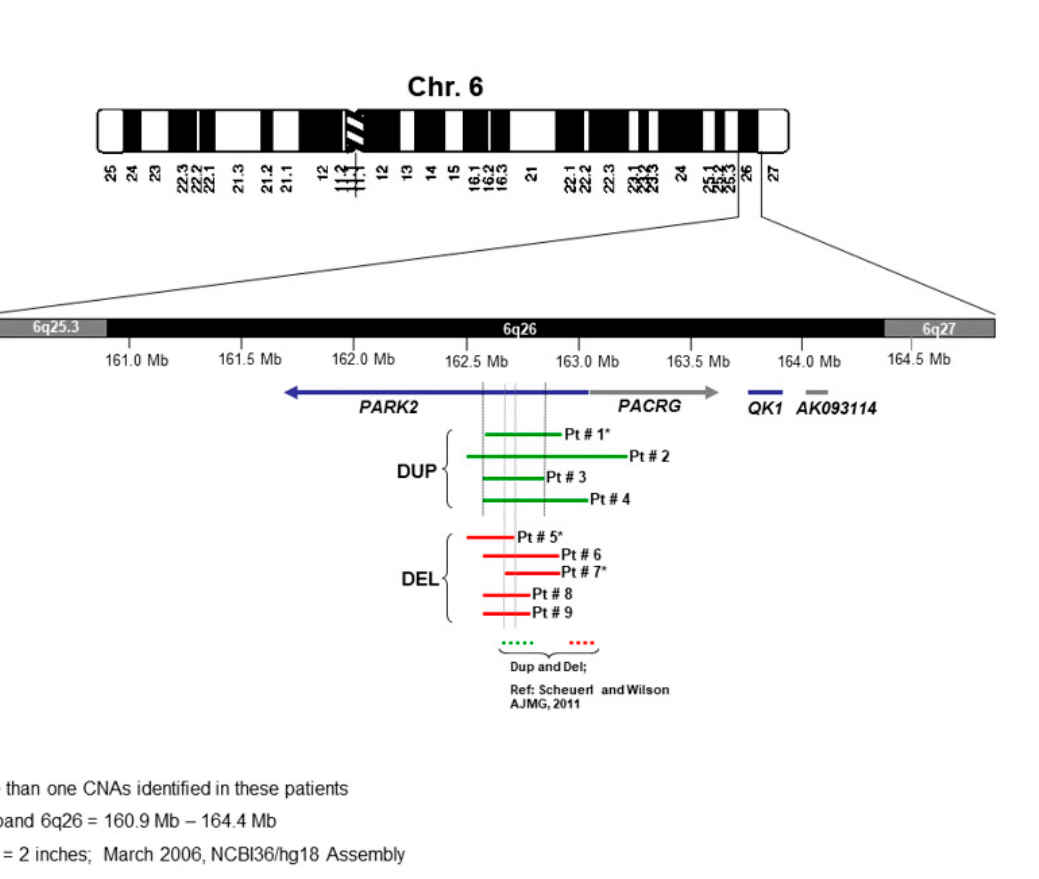
Figure 3. Schematic of chromosome 6 and comparison of the nine cases with deletion/duplication of 6q26 locus (see Table 2).